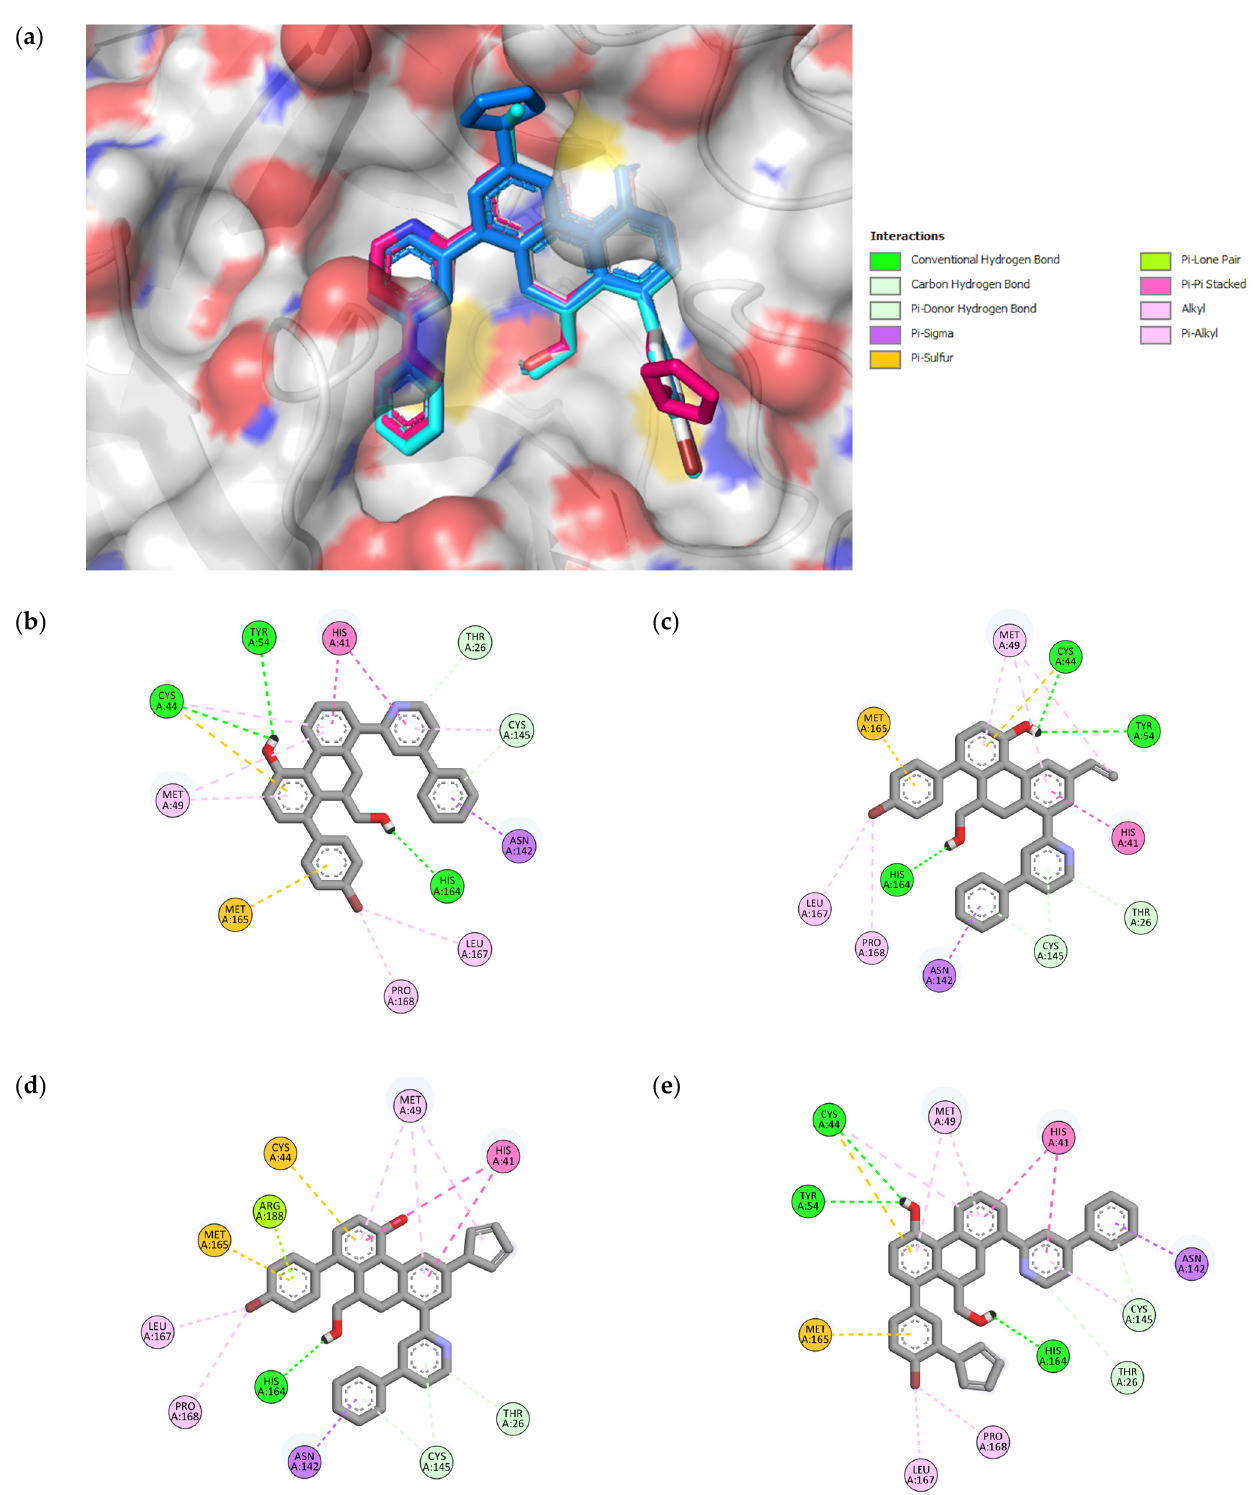
Figure 4. 3D representation of superimposition of the binding poses within the CS of SARS-CoV-2 Mpro of 49 , 49n , 49p , and 49x molecules in white, cyan, magenta and blue color respectively ( a ); 2D representation of interactions within the CS of SARS-CoV-2 Mpro of 49 ( b ), 49n ( c ), 49p ( d ), and 49x ( e ) molecules.